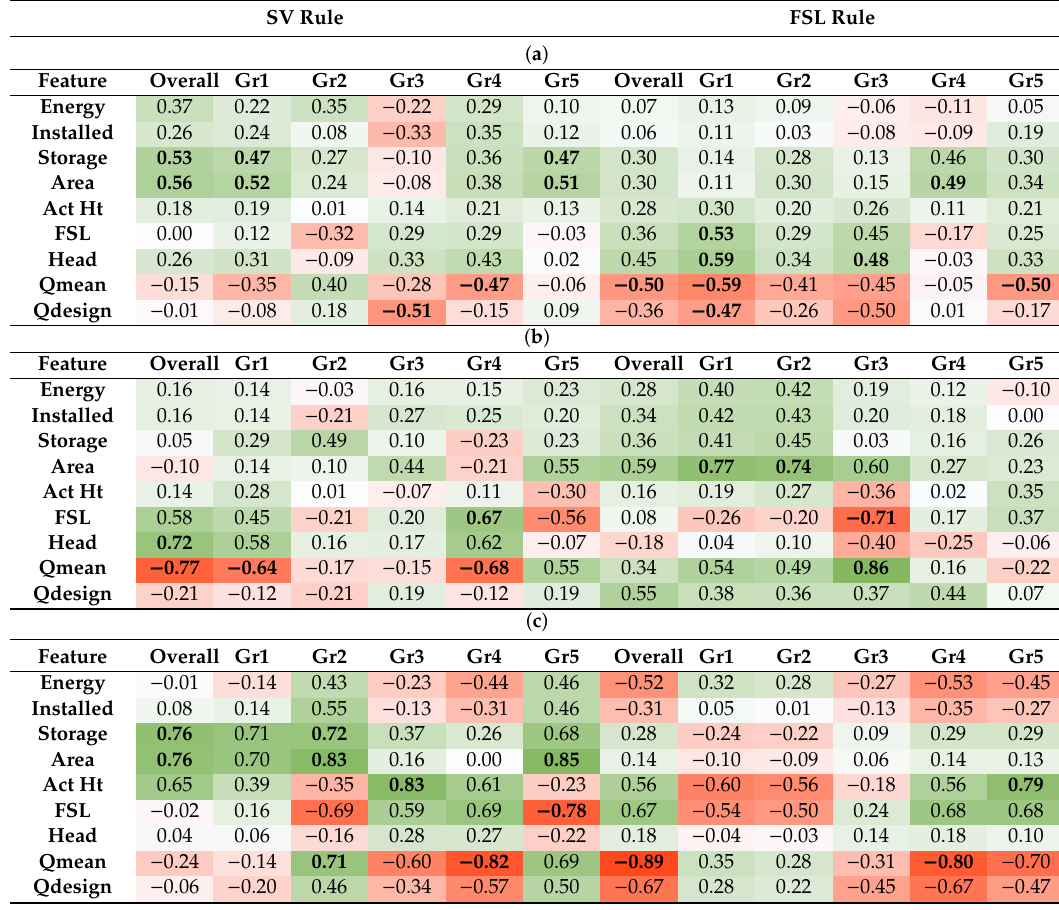
− 0.24 Table 4. Pearson correlation R values for overall HA and IHA parameter groups (Group 1–5 IHA parameters are denoted as Gr1–5), between logarithmic predictor values for features (all notations are described in the caption of Table 3) for the ( a ) Sekong, ( b ) Sesan and ( c ) Srepok sub-basin under the SV-rule curve and FSL-rule curve (green and red indicate positive and negative correlations, bold values represent p < 0.05). SV Rule FSL Rule ( a